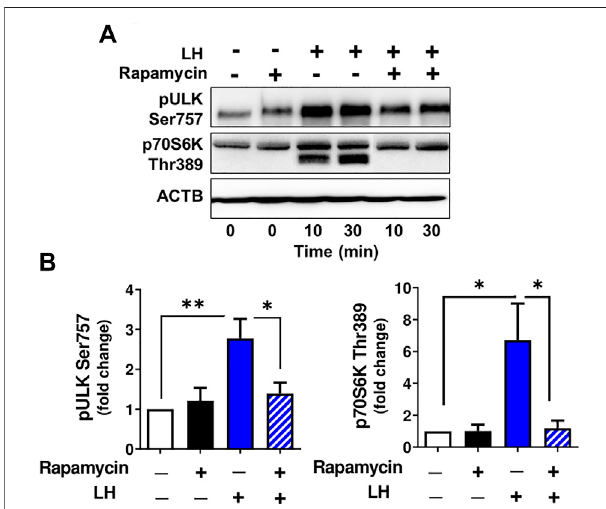
FIGURE6| MTOR signaling triggersULK1 phosphorylation.Small luteal cells were pretreated with MTOR inhibitor rapamycin (50 nM) for 1 h and then treatedwithLH(10 ng/ml)for10and30 min. (A) Representativeimmunoblots showing phosphorylation of ULK1 (Ser757) and p70S6K (Thr389). (B) BargraphsshowingphosphorylationofULK1(Ser757)andp70S6K(Thr389). Datawerenormalizedto β -actin.Statisticalanalysiswasperformedusingone- way ANOVA test for repeated measurements and Bonferroni post hoc test. Signi fi cant differences are indicated with asterisks *, ** representing p < 0.05, p < 0.01.